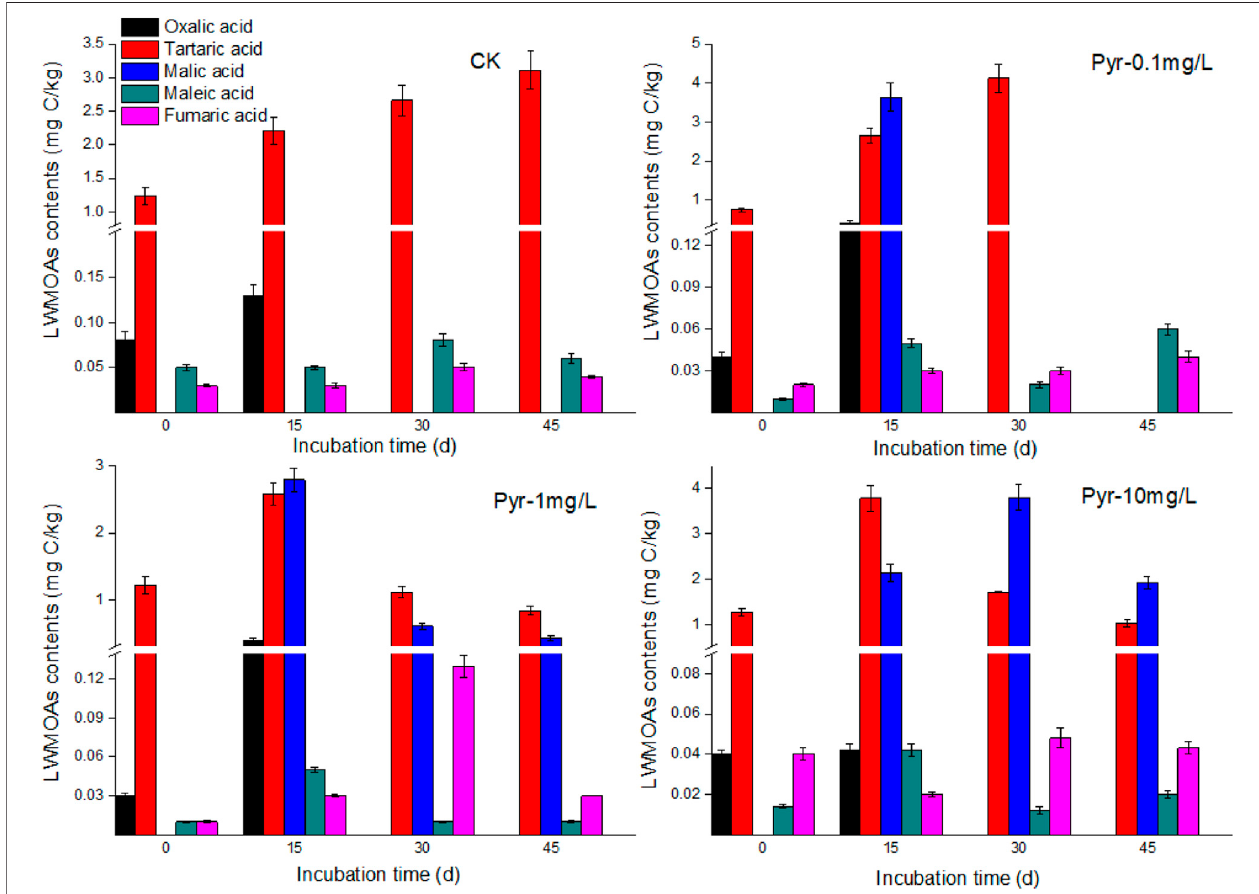
FIGURE 5 | The change of LWMOAs in root exudates under Pyr